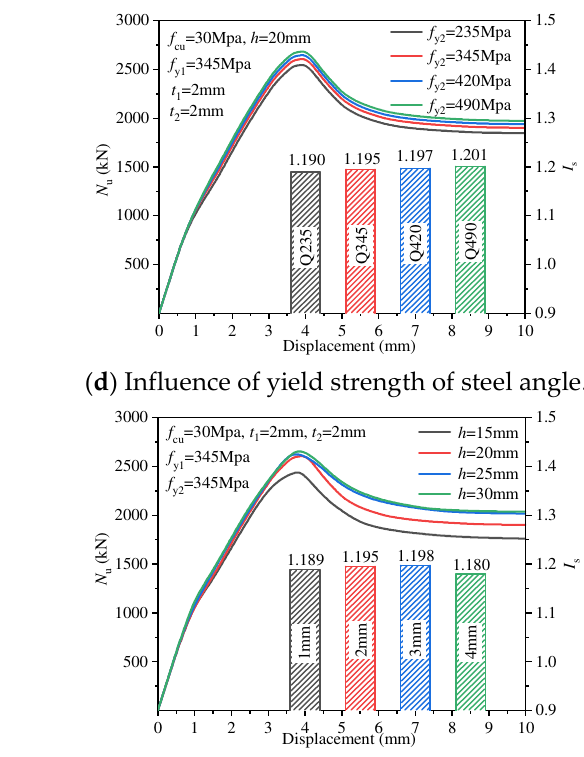
( f ) Influence of wave height of corrugated steel plate. Figure 14. Results of FE parametric analysis. Figure 14. Results of FE parametric analysis. Figure 14. Results of FE parametric analysis.